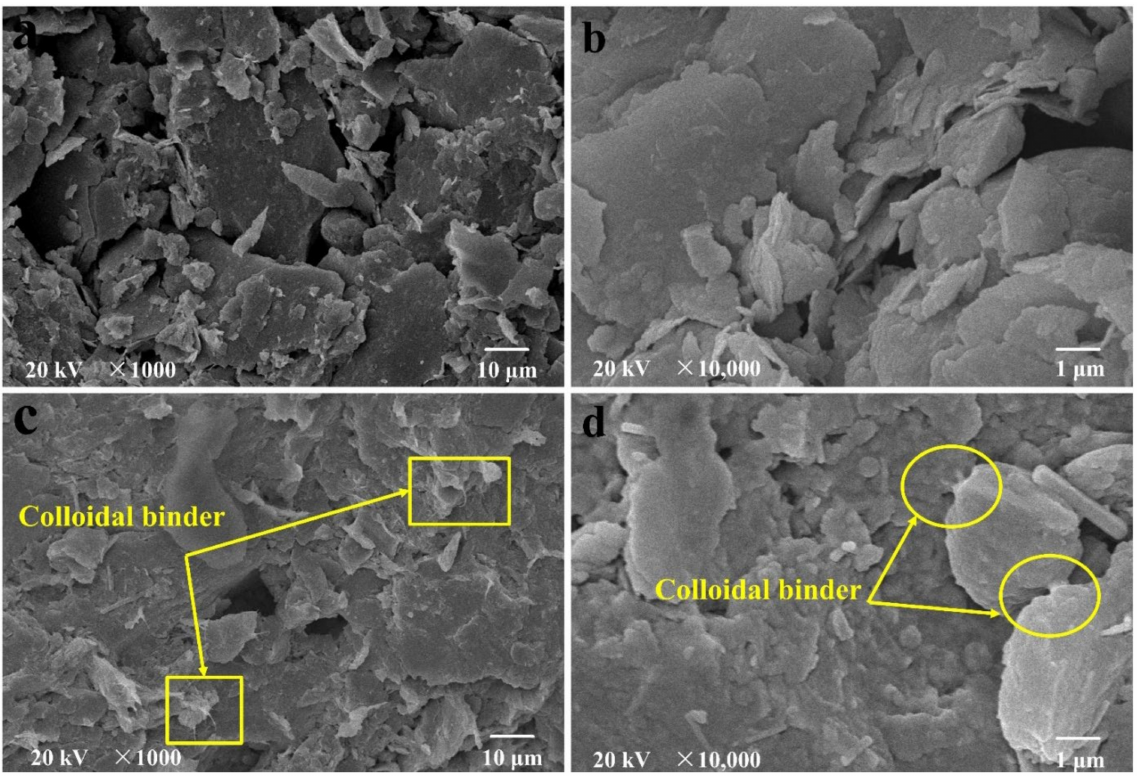
Figure 7. The microstructure of M-0 ( a , b ) and M-10 ( c , d ) before